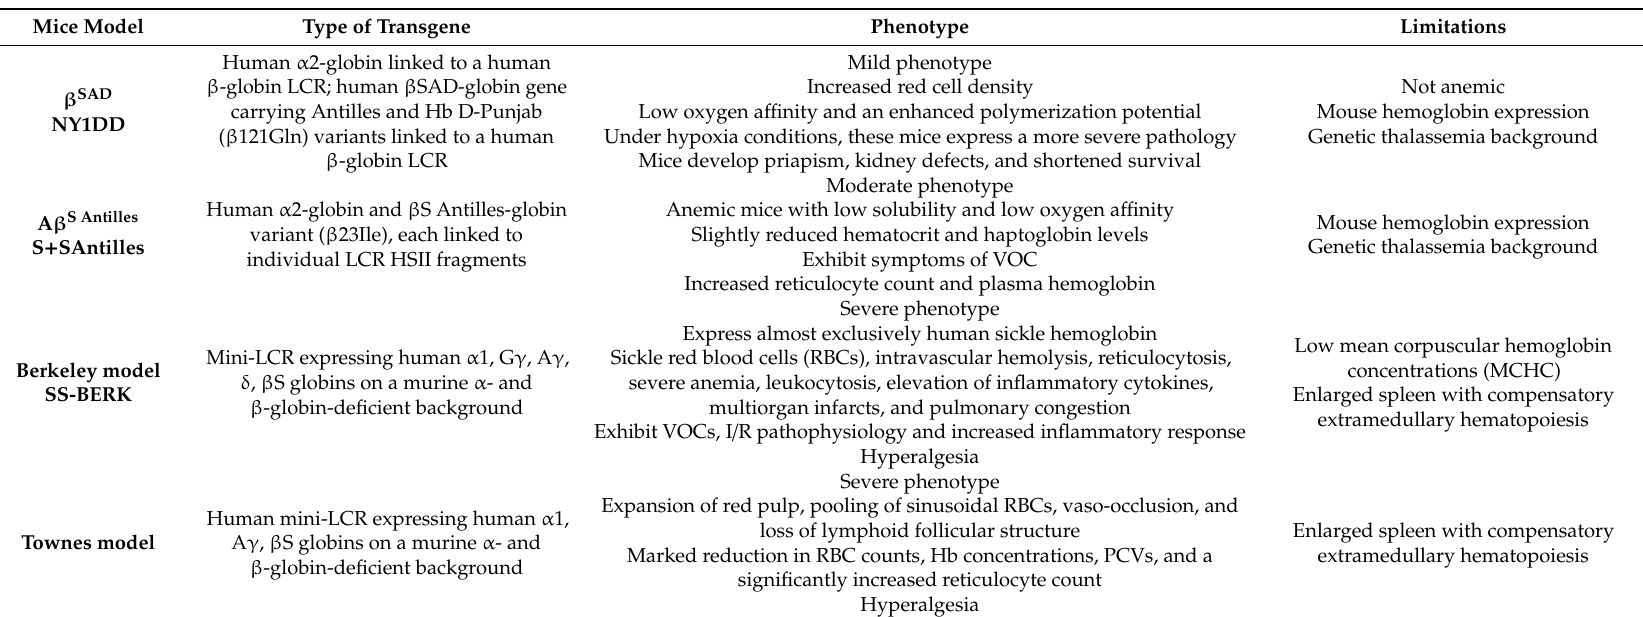
Table 2. Sickle cell disease (SCD) mouse